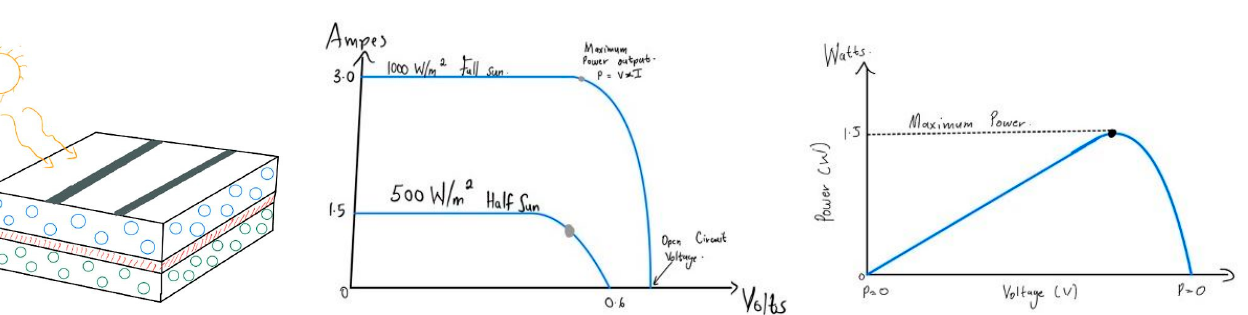
Figure 3. Solar voltaic power output and principles [1,9].